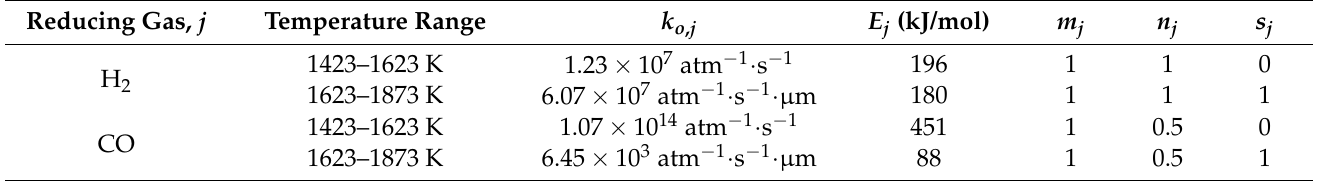
Table 1. Kinetic parameters for reduction of magnetite concentrate by individual component gases [16,17,20,21]. Reducing Gas, j Temperature